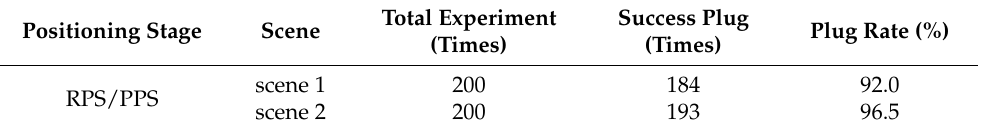
Table 9. CP connection